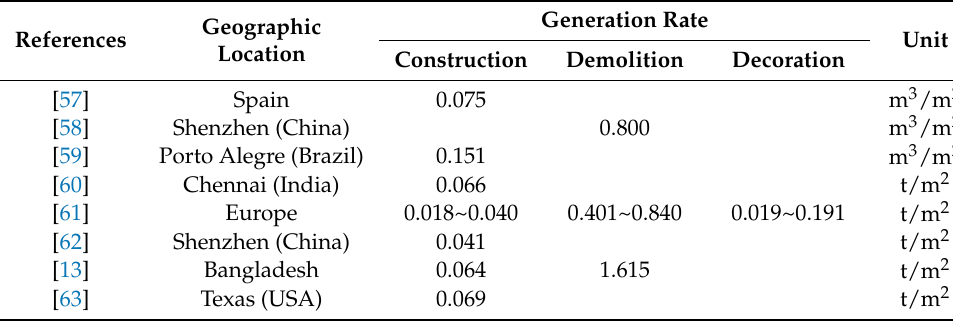
Table 1. The generation rate of CDW in the